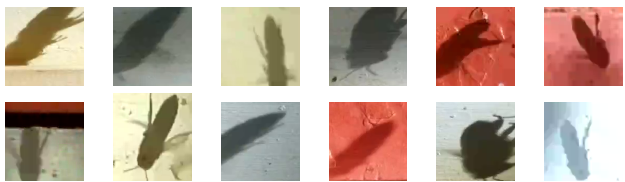
Figure 12. Examples of shadow motion regions that were misclassified as BEE by all convolutional